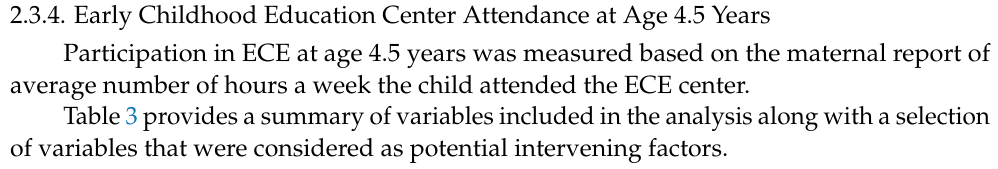
Table 3. Intervening child, parenting and environmental factors from age 18 months to 4.5 years. Opioid- Intervening Factors.